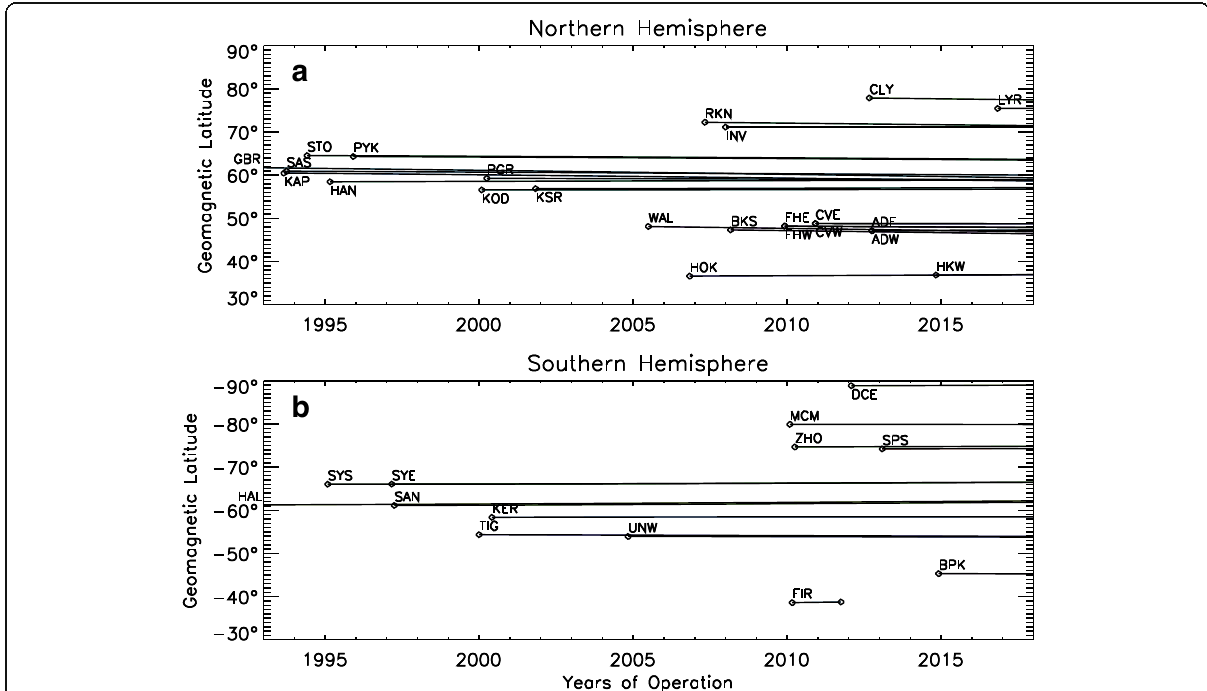
Fig. 6 Timeline of the SuperDARN radars in the a Northern and b Southern Hemispheres. The geomagnetic latitudes are in AACGM-v2 coordinates, changing as a function of